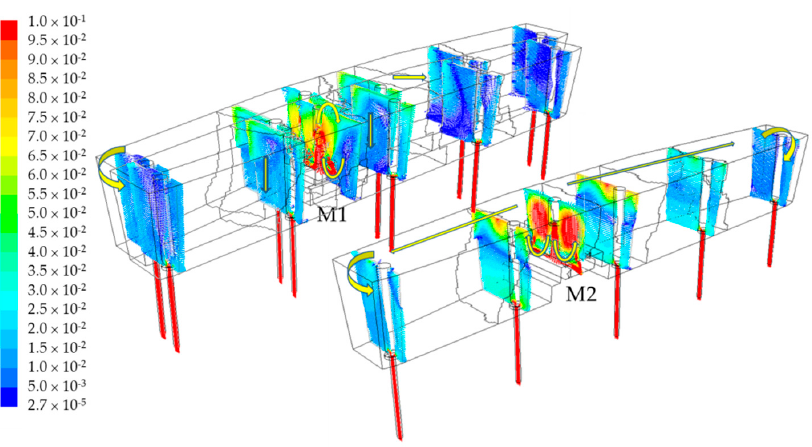
Figure 6. Comparison of velocity vectors (m · s − 1 ) for two tundish configurations in cross-sections through the centre of nozzles.